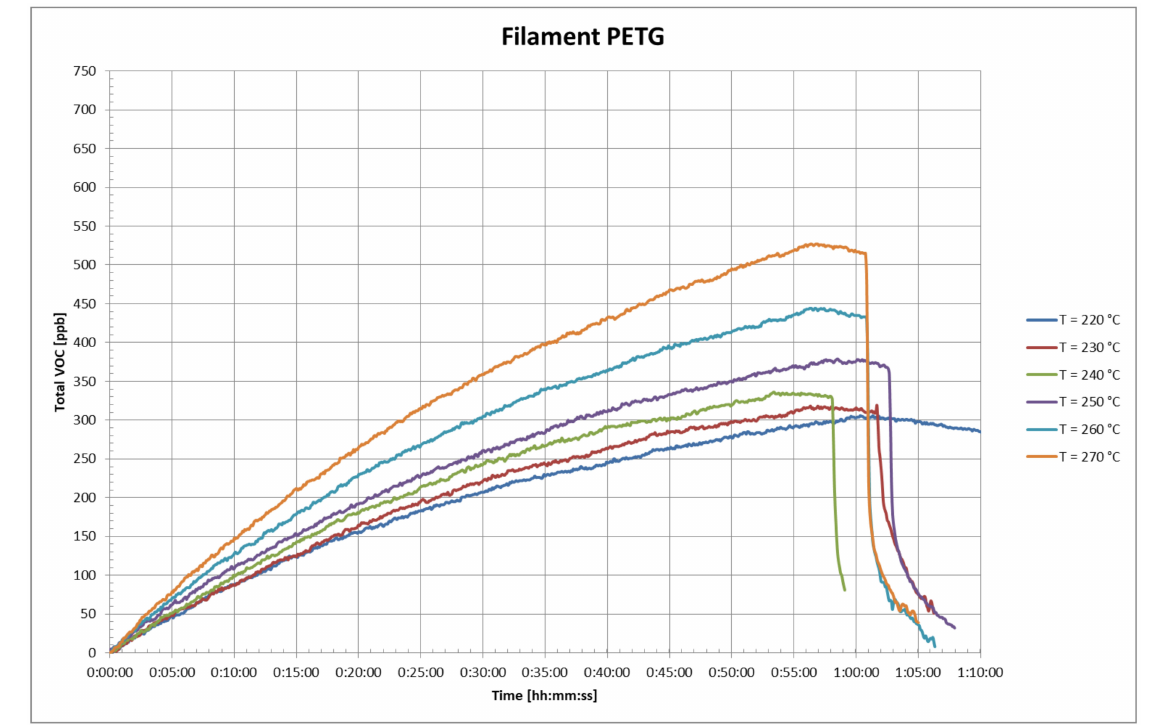
Figure 8. Total volatile organic compound (VOC) concentrations in the test chamber in the case with polyethylene terephthalate (PETG)